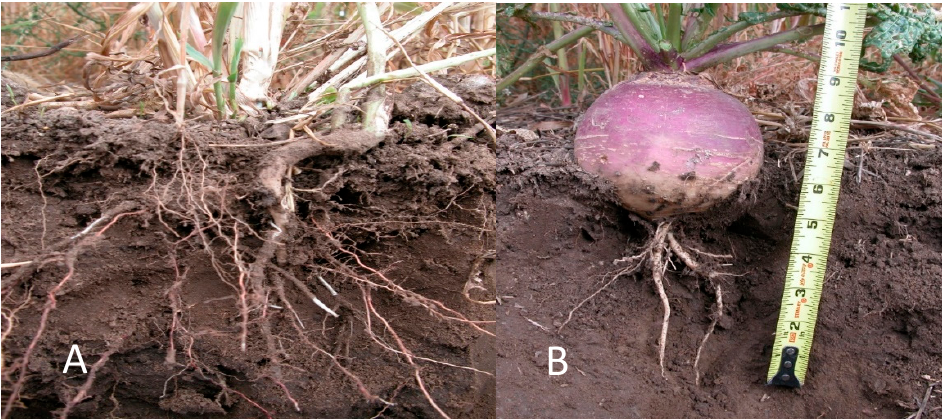
Figure 6. An image showing roots for ( A ) sorghum and ( B ) turnip through dense soil layers in the cover crop mix treat- ment.